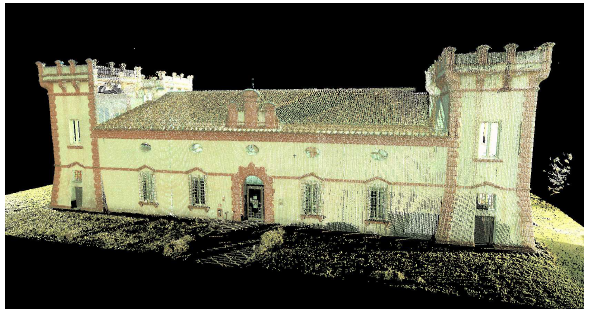
Figure 3: The TLS point clouds of the Castle